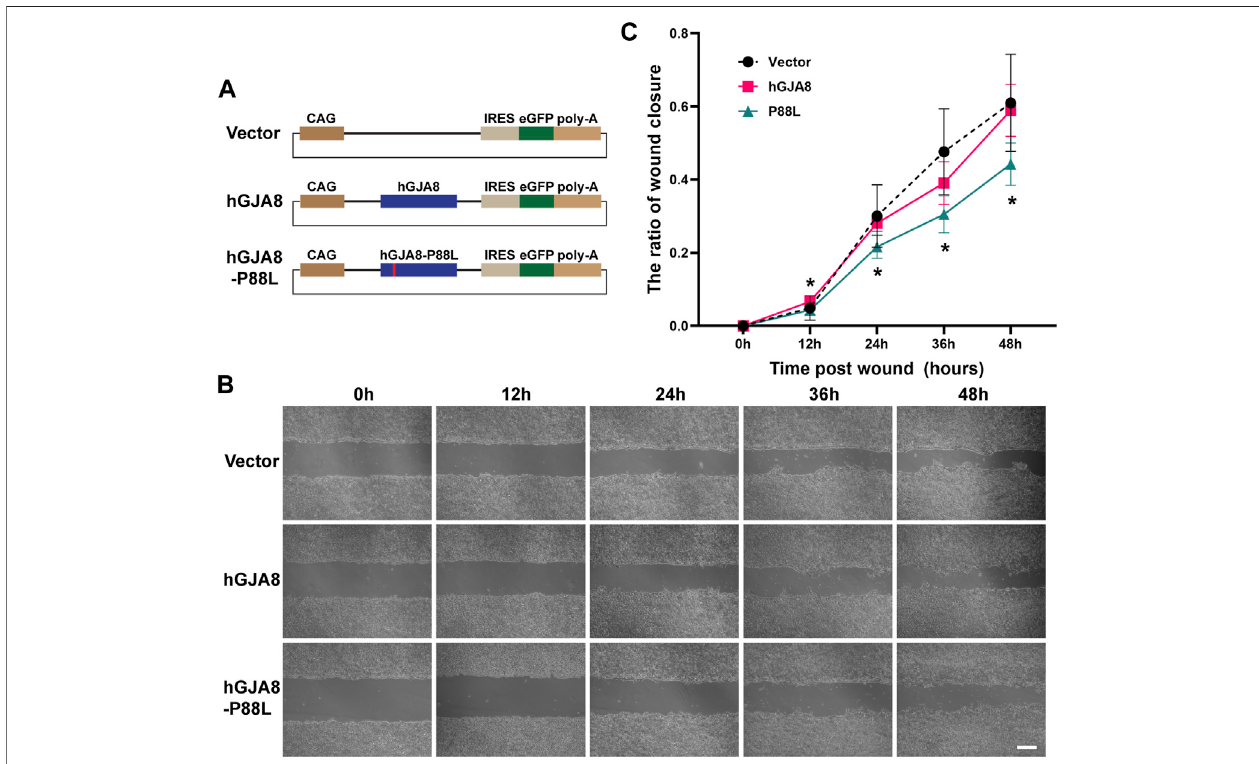
FIGURE 4 | Overexpression of P88L inhibits human LECs migration. (A) Illustration of pCIG-vector, pCIG-hGJA8 and pCIG-hGJA8-P88L plasmids used for transfection. (B) HumanLECsweretransfectedwiththeindicatedplasmids.Cellswerescrapedtocreatewoundsofsimilarsizes.Representativeimageswerecaptured at timepoints 0 h (hour), 12, 24, 36 and 48 h after cell scratches. Scale bar: 200 µm. (C) The wound closure ratios were calculated at each timepoint by ImageJ. The asterisk ‘ * ’ represents a signi fi cant difference ( p < 0.05; N = 6 for GJA8 and vector, N = 8 for P88L) between P88L and wildtype GJA8 or vector at the